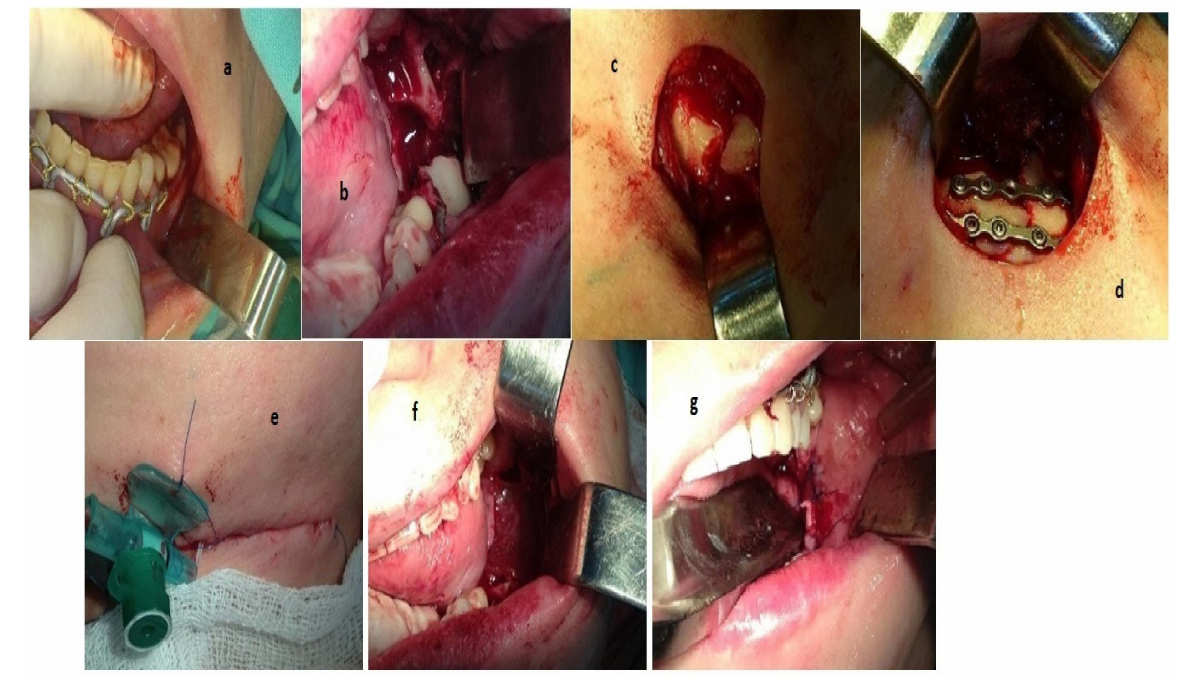
Figure 3. ( a ) Teeth 3.6, 3.7 and 3.8; ( b ) founded bone cavity and fracture line; ( c ) fracture line visualization; ( d ) osteosynthesis; ( e ) sutured skin after the intervention; ( f ) the membrane covers